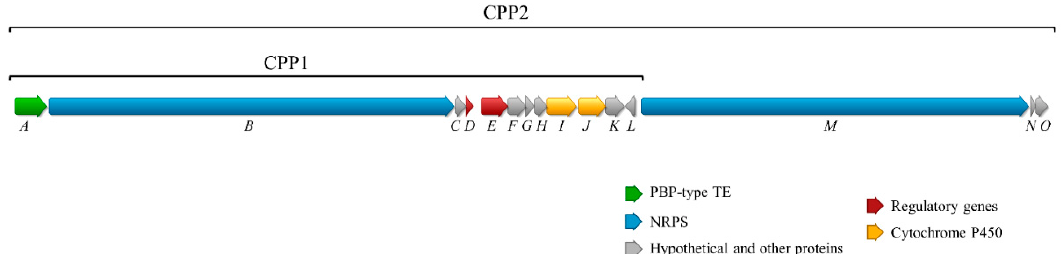
Figure 4. cpp biosynthetic gene cluster. It contains two non-ribosomal peptide synthetases (NRPS) genes (blue), one Penicillin Binding Protein (PBP)-type thioesterase (TE) gene (green), two cytochromes P450 (yellow), two regulatory genes (red) and other genes with unknown functions (grey). The two fragments cloned by CATCH into vector pCAP01 are indicated: the 28.7 Kb CPP1 fragment contains the PBP-type TE gene ( cppA ), the NRPS1 gene ( cppB ) and the genes present between NRPS1 and NRPS2 ( cppC-cppL ); the 48 Kb CPP2 fragment includes the above described 28.7 Kb fragment and the NRPS2 ( cppM ), cppN and cppO genes.